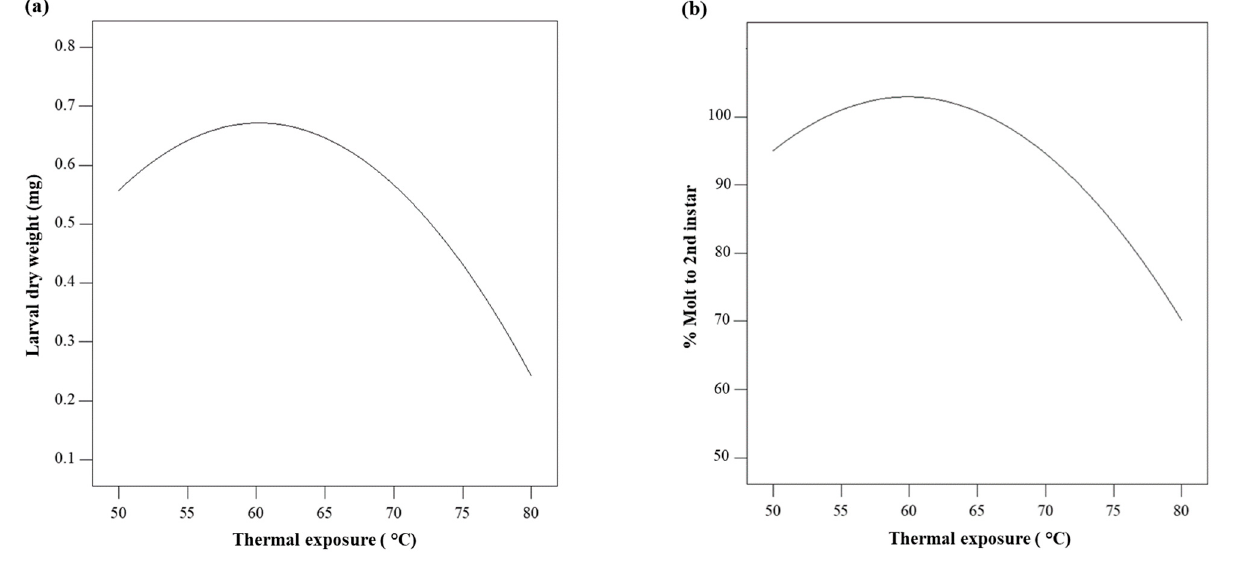
Figure 4. Nonlinear effects of mild thermal exposure (50–80 °C) for 15 min on dry weight ( a ), percent successful completion of molt to 2nd instar ( b ), and percent successful completion of molt to 3rd instar ( c ). Western corn rootworm larvae reared on WCRMO-2 diet for 10 days. 4.3. Contamination All experiments had minor contamination (<3%) except for diet treatments that ex- perienced a soft-set of the media that were excluded from the analyses. No evidence for a relationship between contamination and two experimental factors (thermal exposure and time of thermal exposure) was determined. Similarly low contamination rates were ob- served previously [27]. 5. Discussion Published WCR diets require antibiotics as diet preservatives to alleviate bacterial contamination [24,25,27]. However, ingestion of antibiotics results in changes in WCR gut microbiota [31], thereby possibly interfering with the determination of the susceptibility of WCR to insecticide toxins using diet bioassays. The availability of a WCR diet free of